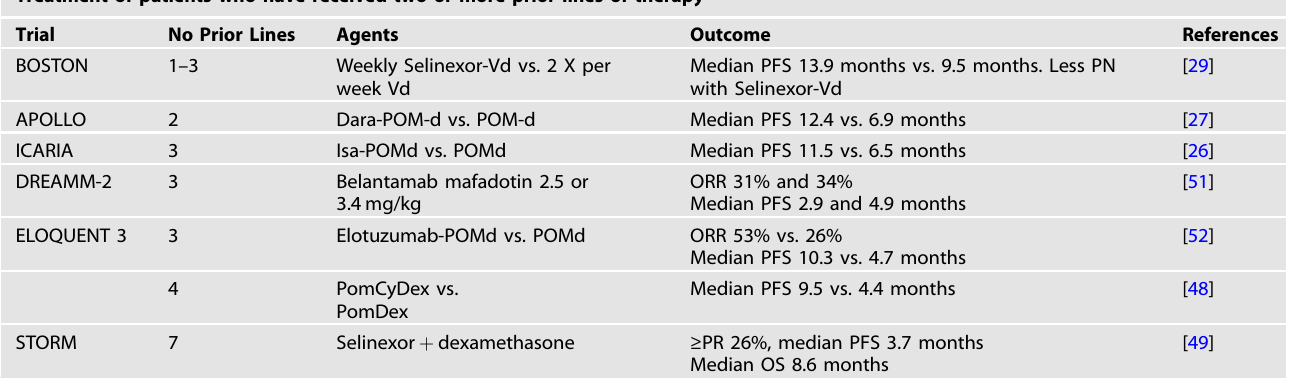
Table 3. Possible treatments for patients who have received two or more prior lines of therapy. Treatment of patients who have received two or more prior lines of